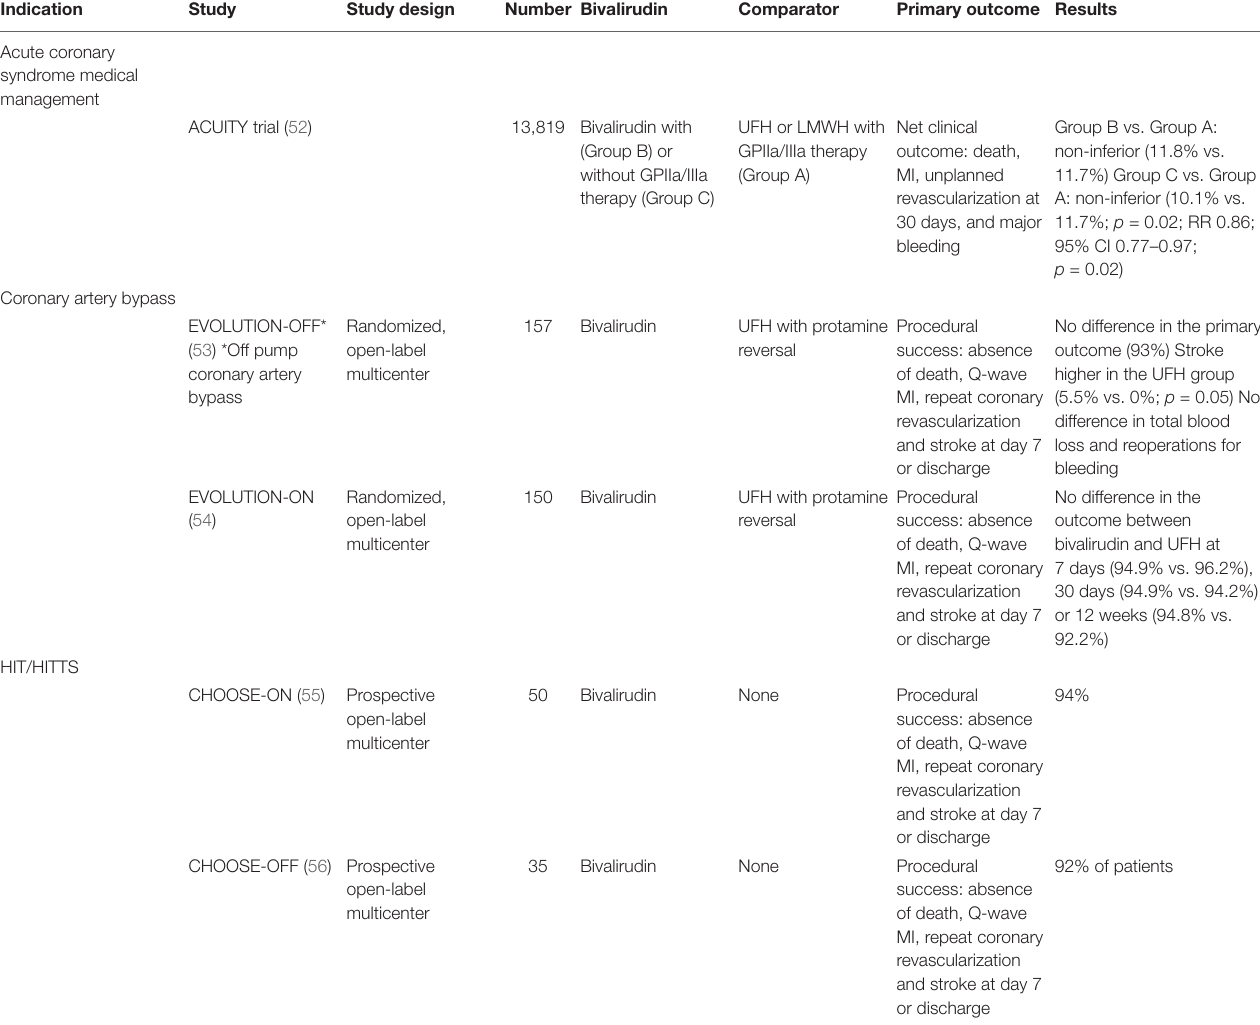
TABLE 2 | Bivalirudin trials in adults. Indication Study Study design Number Bivalirudin Comparator Primary outcome